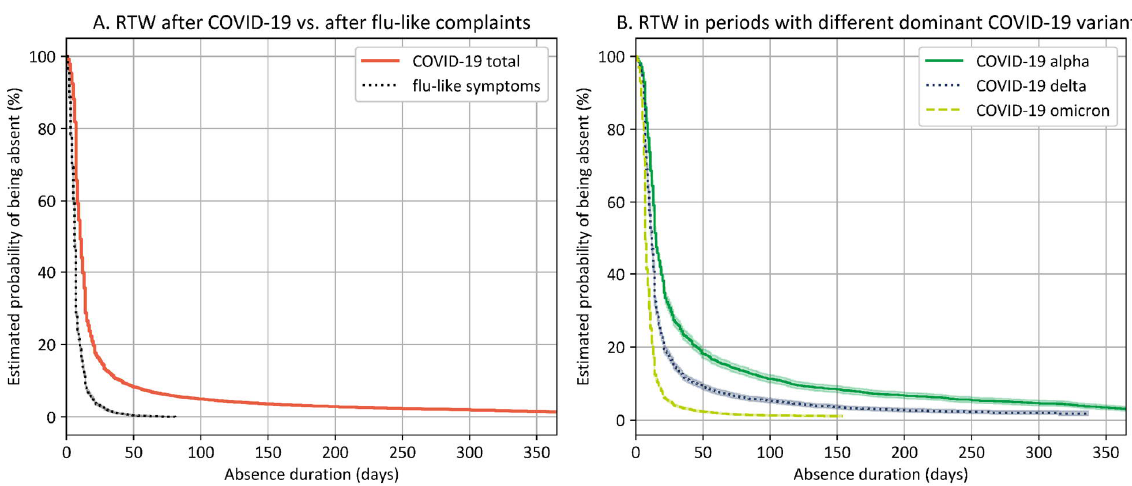
Figure 2. A) Survival curve of employees with self-reported COVID-19 between 19 March 2020 and 18 March 2022 (COVID-19 total), referenced against employees with self-reported flu-like symptoms in the same time period. B) Survival curves of employees with self-reported COVID-19 in time periods with different dominant variants. Variant dominance information was taken from the Dutch National Institute for Public Health and the Environment (RIVM; coronadashboard.government.nl/landelijk/varianten ). Error bands represent exponential Greenwood confidence intervals.